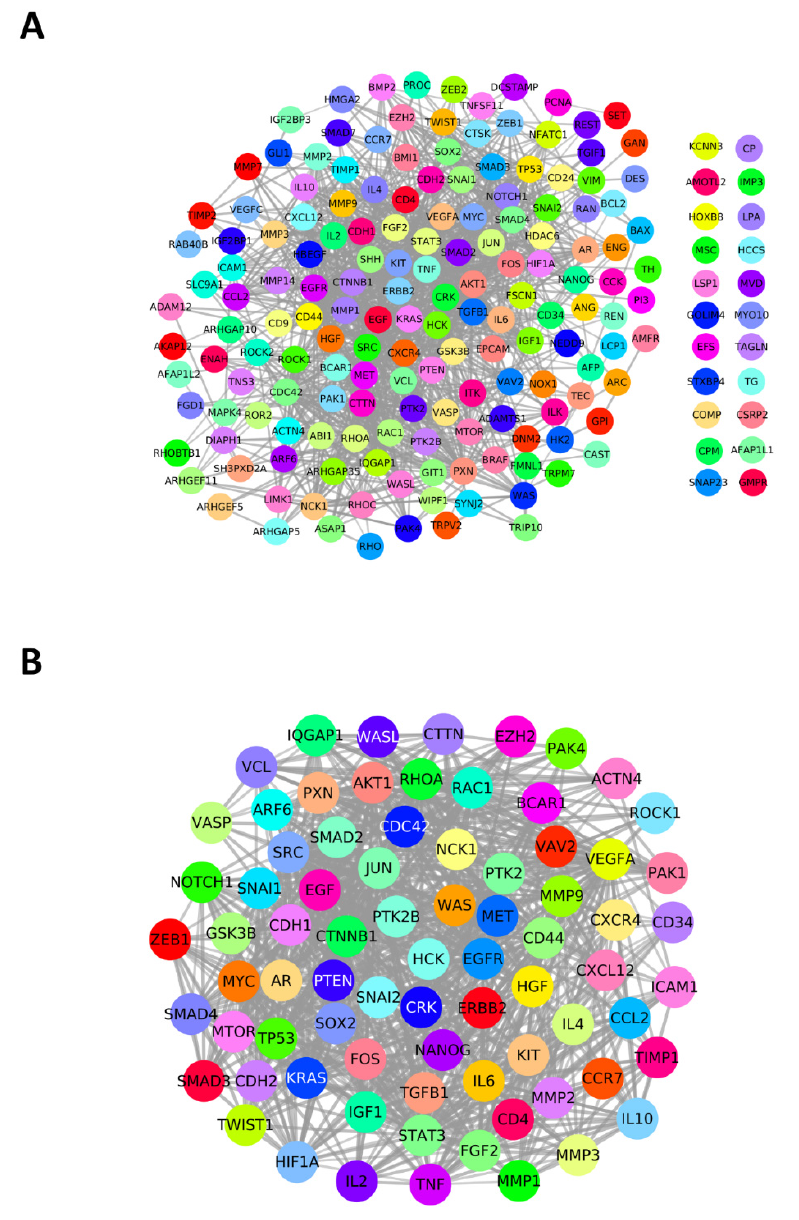
Figure 3. Protein–protein interaction (PPI) networks of genes and significant gene modules. ( A ) High-confidence (0.7) PPI network (STRING) of 185 unique genes involved in metastasis-related processes. ( B ) PPI network of the candidate hub genes (MCC and MCODE).